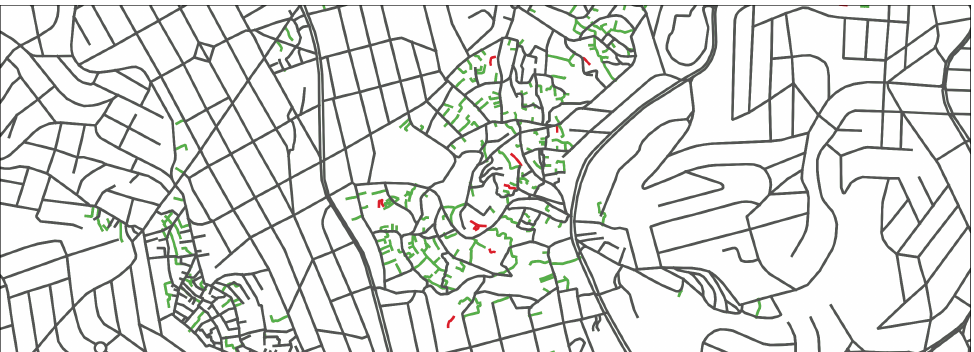
Figure 6. Exclusive pedestrian segments from HVTL integrated with OSM dataset. Segments in black represent the OSM original dataset. Segments in green represent the exclusive pedestrian segments in HVTL that were integrated with OSM. The ones in red were not integrated as they are far from any segment in OSM. The UTM bounding box of this area is (606,757.440, 7,793,281.679, 610,038.036, 7,794,457.742) with EPSG =